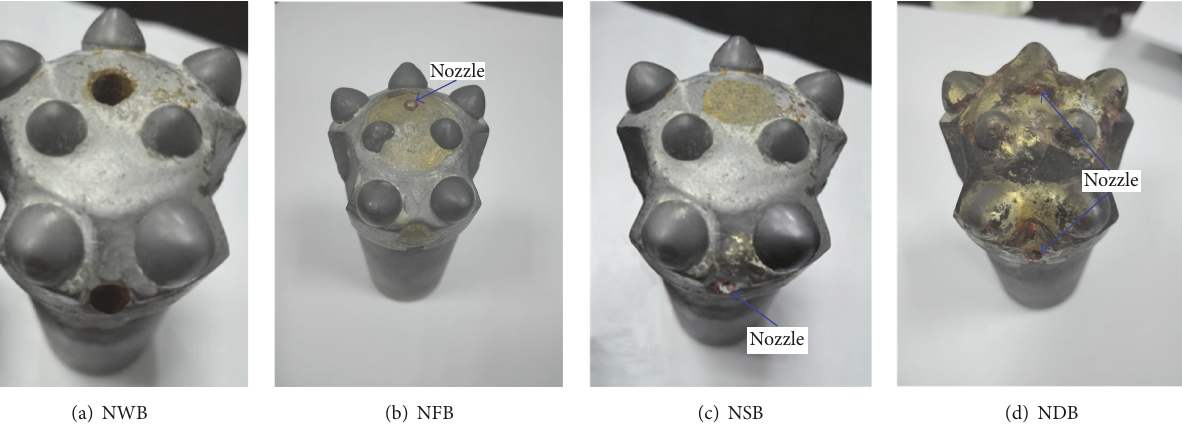
Figure 7: Different configuration bits.